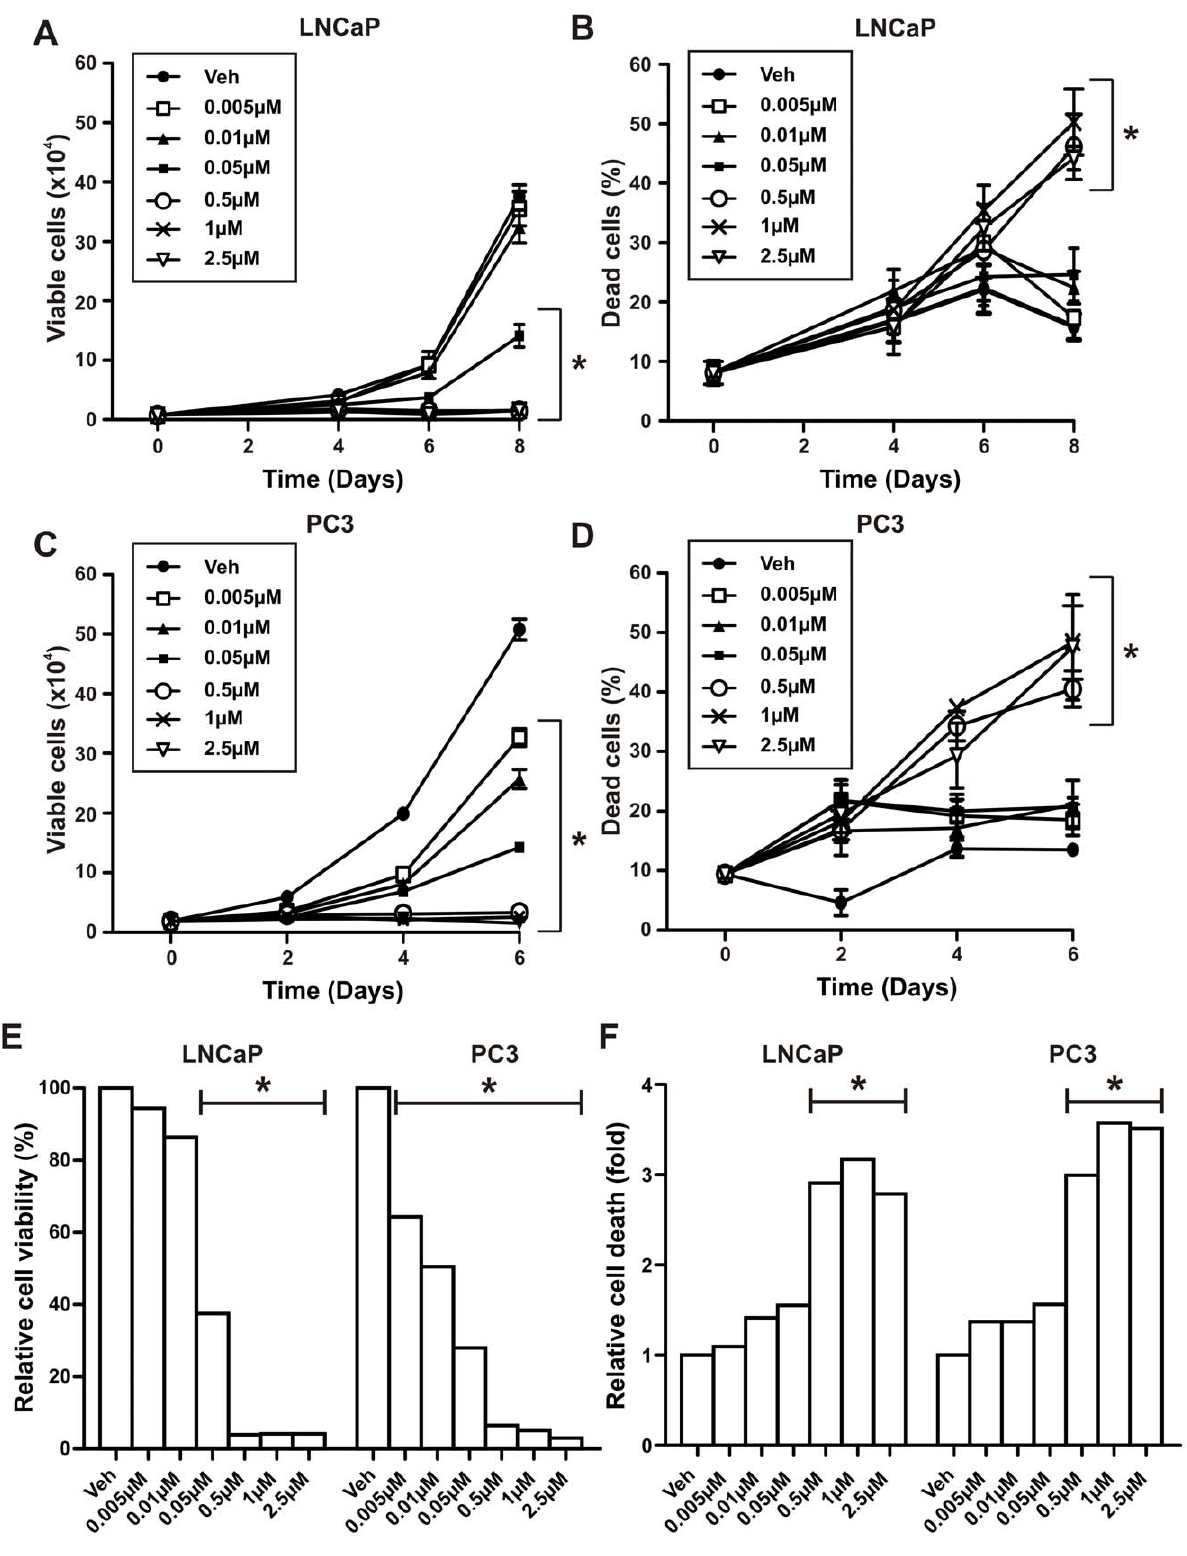
Figure 2. Daily 5-aza-CdR treatment of LNCaP and PC3 prostate cancer cells. (A–B) LNCaP and (C–D) PC3 prostate cancer cells (1 6 10 4 cells per well in 12-well plates) were treated with increasing doses of 5-aza-CdR (0.005–2.5 m M) replenished daily for up to 8 days. (A) and (C) cells were counted at regular intervals using a hemocytometer and the number of viable cells was assessed by Trypan blue dye exclusion. (B) and (D) the number of dead cells is expressed as a percentage of the total number of cells counted. (E) and (F) relative cell viability following 6 or 8 days of treatment with 5-aza-CdR was presented as the percentage of viable cells compared to vehicle control (veh) and relative cell death as the fold of